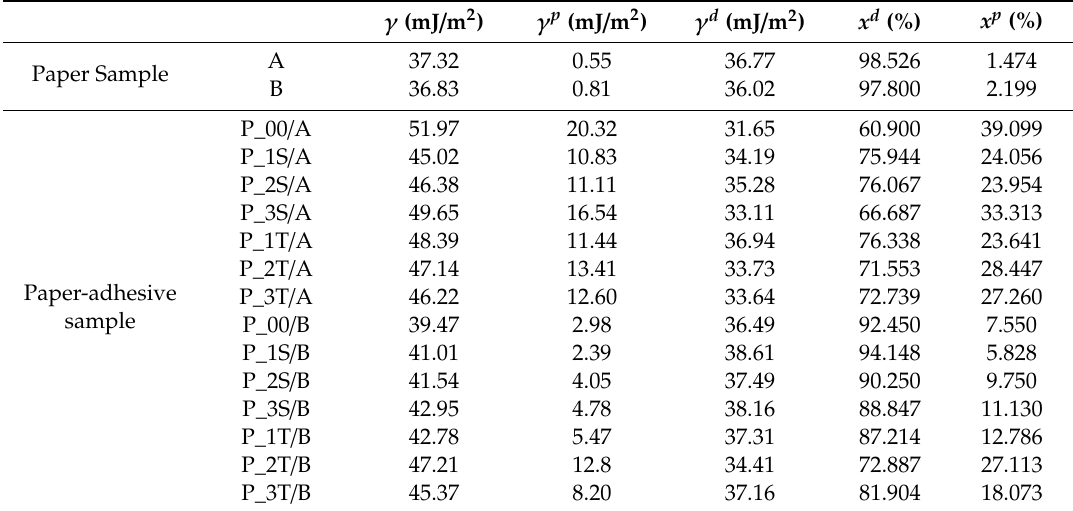
Table 5. Surface free energies ( γ ), polar ( γ p ) and dispersive ( γ d ) components, dispersive and polar indexes ( x d , x p ) of papers and paper-adhesive samples according to OWRK method.